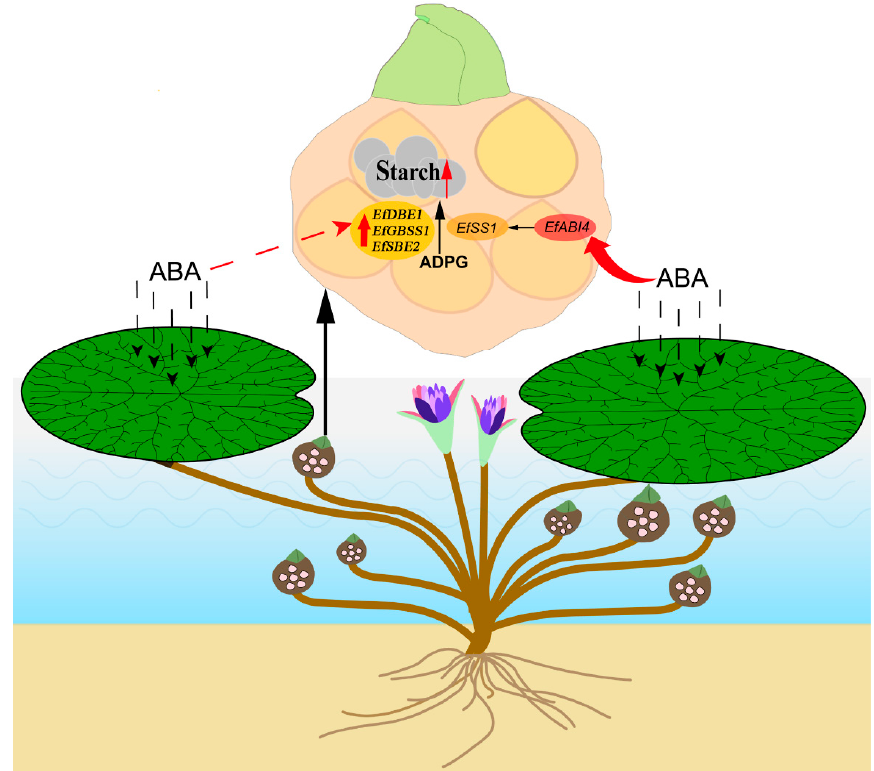
Figure 5. The model of ABA regulating starch biosynthesis in E. ferox seeds.